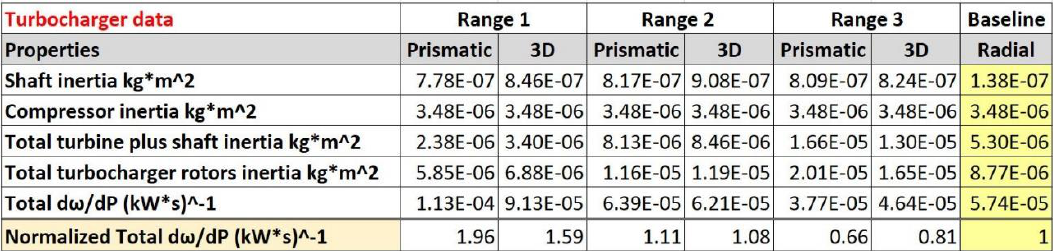
Table 4. Summary of Design of Experiment details at the final design